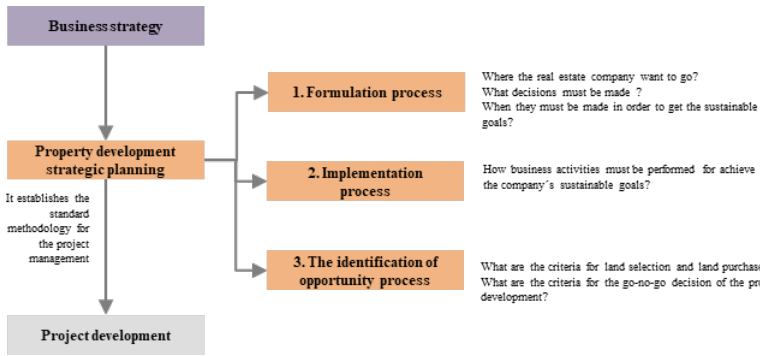
Figure 7. The new business investment vision and the main drivers of the sustainable business strategy (source: Kerzer, 2001; Porter & Kramer,